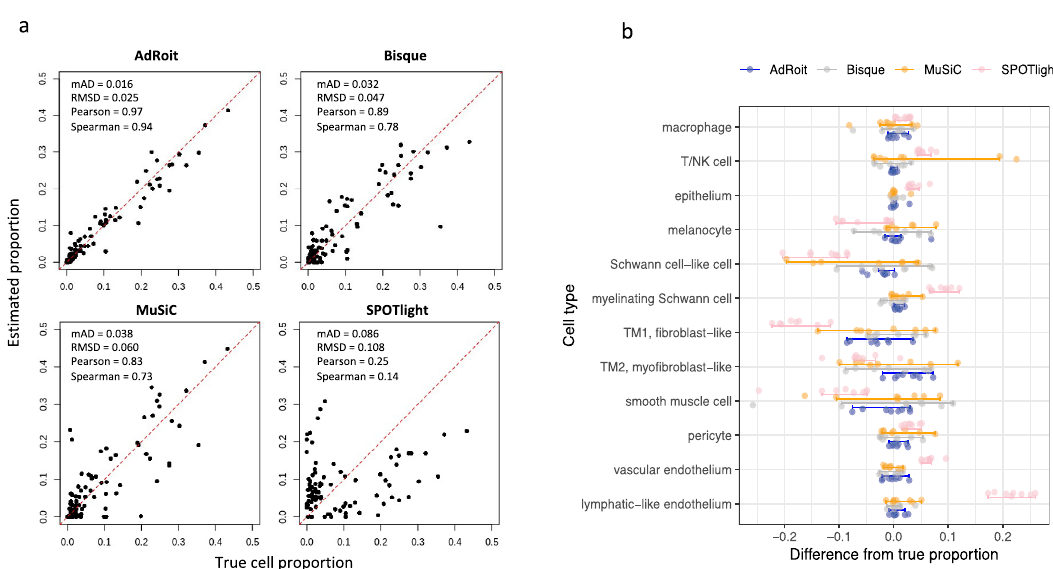
Fig. 2 Benchmark on simulated bulk data generated from the trabecular meshwork (TM) single cells. a AdRoit has the closest estimation to the true cell proportion comparing to Bisque, MuSiC, and SPOTlight. Each dot is a cell type from a donor. The performance metrics were derived from eight distinct donors. b For each cell type in TM, AdRoit has the smallest differences from the true cell type proportion and the smallest variance of estimates across eight distinct donors. For each cell type, a dot on the graph denotes a donor, and the bars represent the 1.5× interquartile ranges. The reference and gene weight estimations used for deconvoluting each synthetic bulk sample exclude the data from that sample